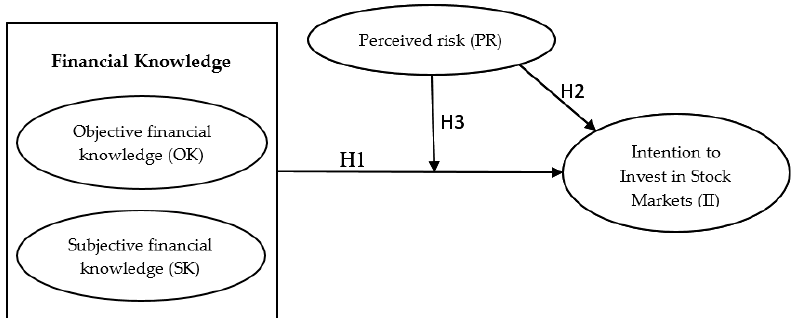
Figure 1. Conceptual framework. Source: Prepared by researchers from the literature review and research gap.